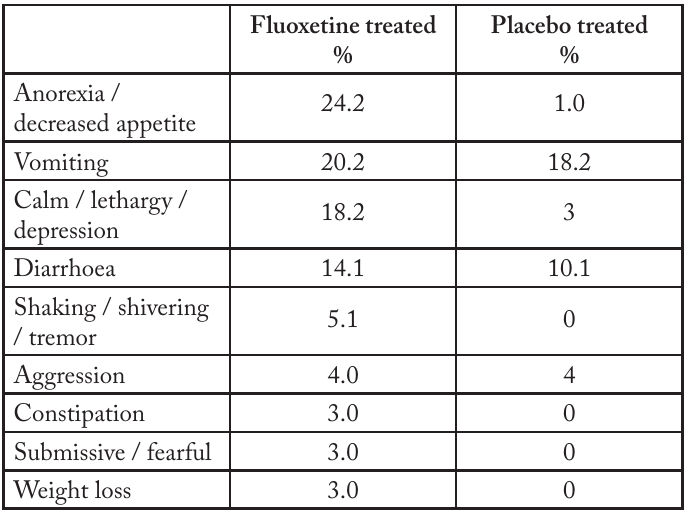
Table 2: Percentage of fluoxetine and placebo treated dogs recording adverse